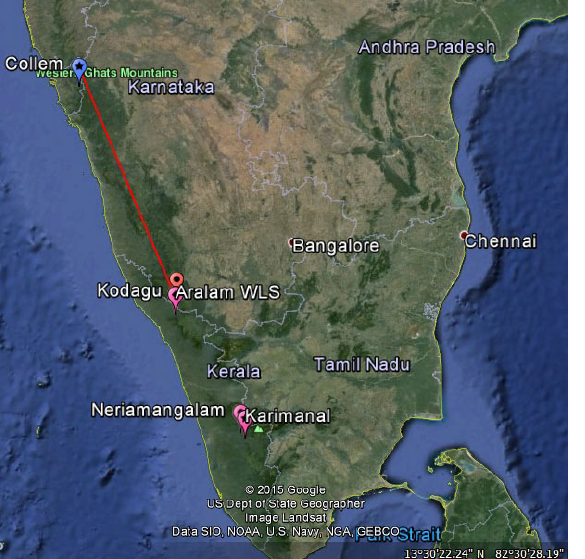
Image 1. Map showing range extension of species and distribution with current record